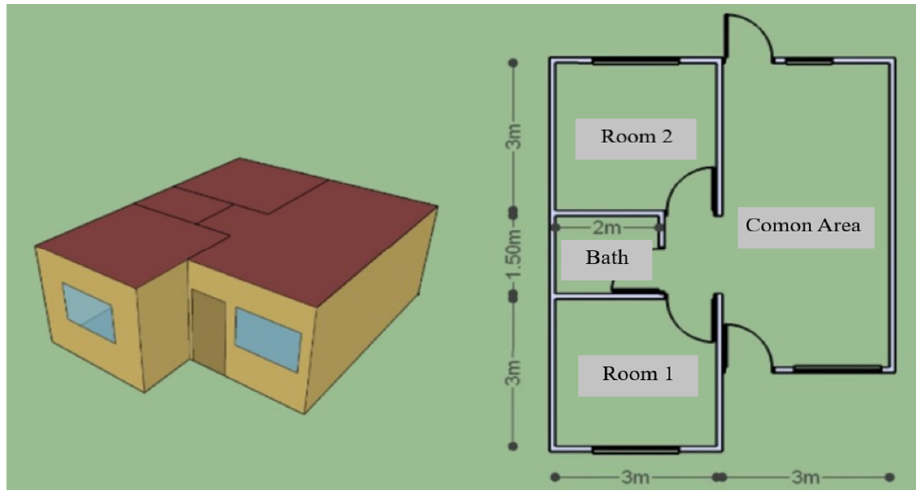
Figure 2. Three-dimensional sketch and layout of the building.